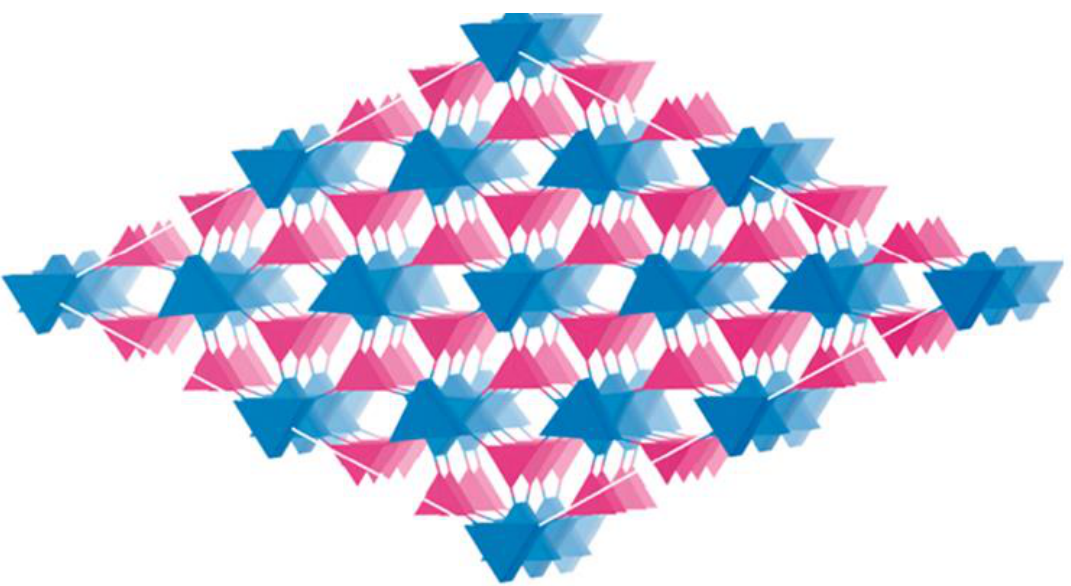
Figure 4. The structure of 3D COF-trip with ceq net. Reprinted (adapted) with permission from [22]. Copyright {2021} American Chemical Society.